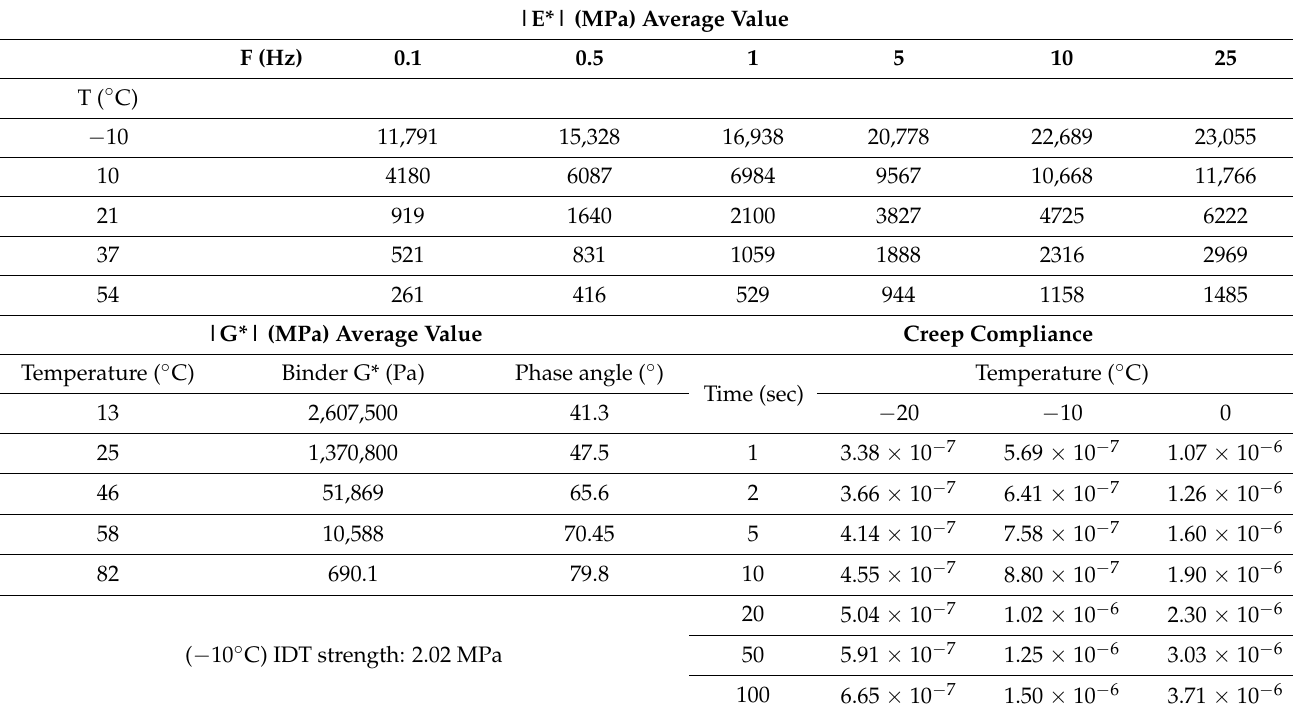
Table 7. Pavement M-E input for 19 mm-rubber-HMA.